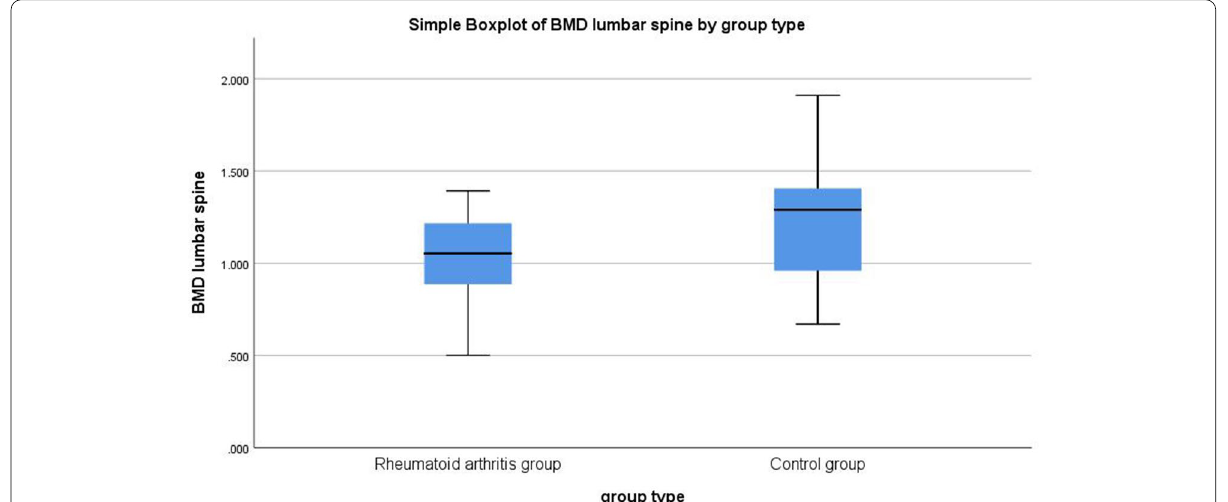
Fig. 1 BMD of the lumbar spine (in gm/cm 2 ) mean was lower significantly in the RA group in comparison with the control ( P